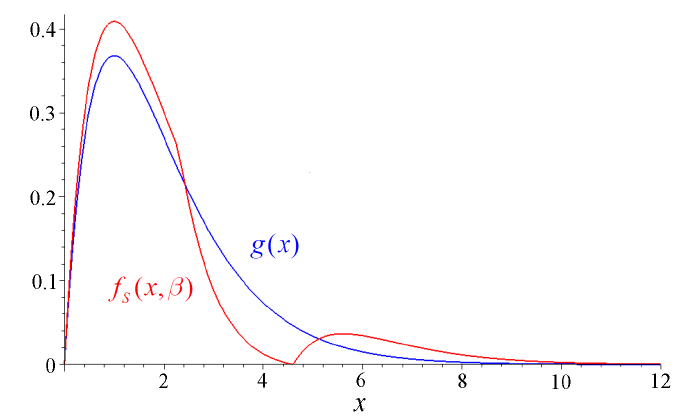
Figure 3: Plots of the densities f S ( x , β ) for β = 0.1 and g ( x ) in Example